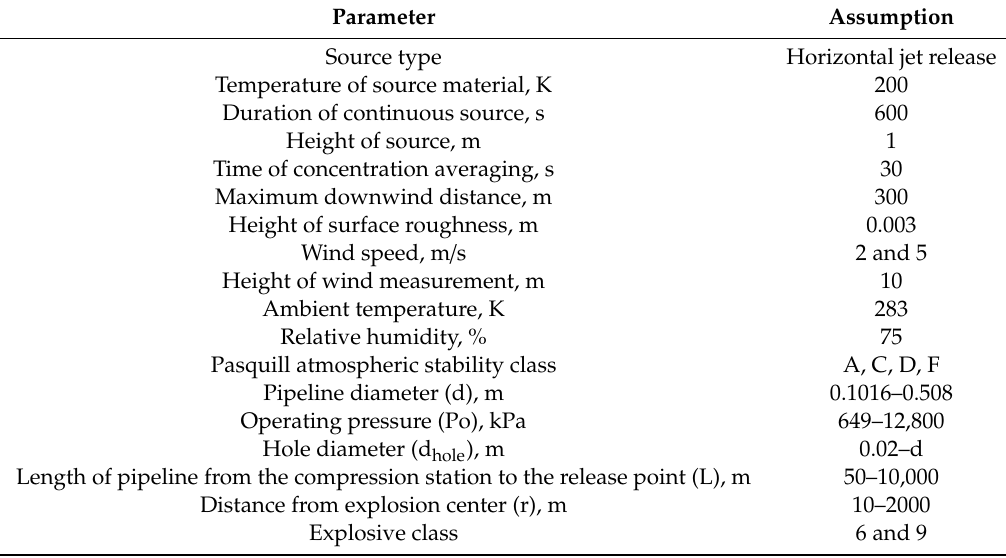
Table 2. Simulation